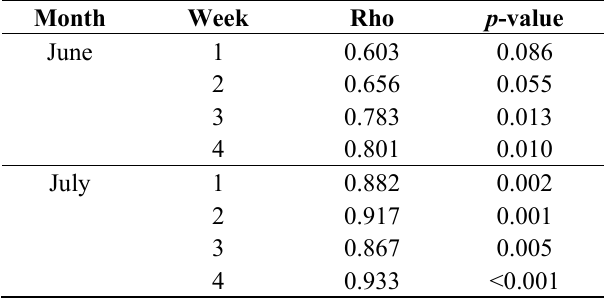
Table 2. Spearman rank correlations between cumulative case numbers through July and August and total annual case numbers from 2004–2012 ( N = 9).